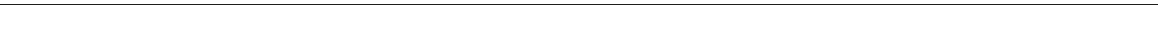
Fig. 2 TMEM106B knockdown suppresses invasion and metastasis. a qPCR analysis for TMEM106B expression in 344SQ cells with stable expression of shRNA targeting TMEM106B versus a scramble control. b Western blot analysis for TMEM106B expression in 344SQ cells with stable expression of shRNA targeting TMEM106B. c The TMEM106B knockdown cells demonstrate reduced ability to migrate and invade compared to scramble controls. d The knockdown cells suppress formation of invasive structures in a 3D matrix upon treatment with TGF β . e The knockdown cells were injected subcutaneously into syngeneic hosts and observed for primary tumor growth and f formation of metastatic nodules in lungs. g Representative lungs and their respective H&E sections are shown. Lungs from mice injected with TMEM106B knockdown cells show signi fi cantly reduced incidence of lung metastasis. All asterisks indicate statistical signi fi cance by t test ( n ≥ 3, * p ≤